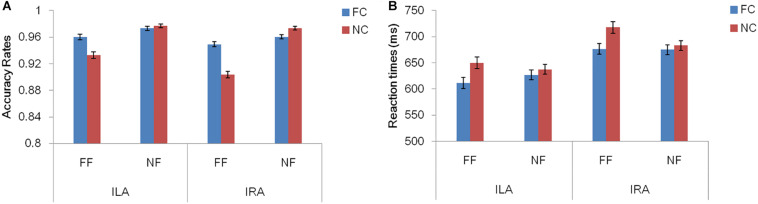
The accuracy rates (A) and response times (B) for the four conditions, for ILA and IRA, respectively. FC: fear cue; NC: neutral cue; FF: fearful face; NF: neutral face.